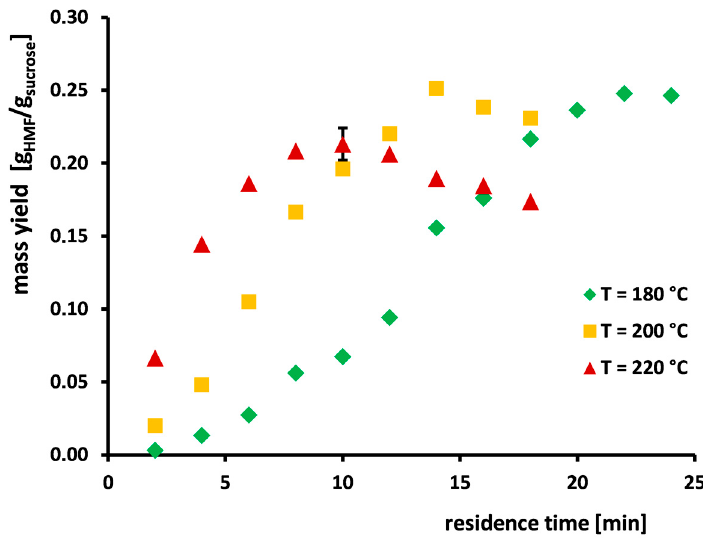
Figure 3. HMF mass yield after acid-catalyzed conversion of sucrose at different residence times and reaction temperatures (T). Feedstock contained 2 wt % sucrose and 0.005 mol/L sulfuric acid.